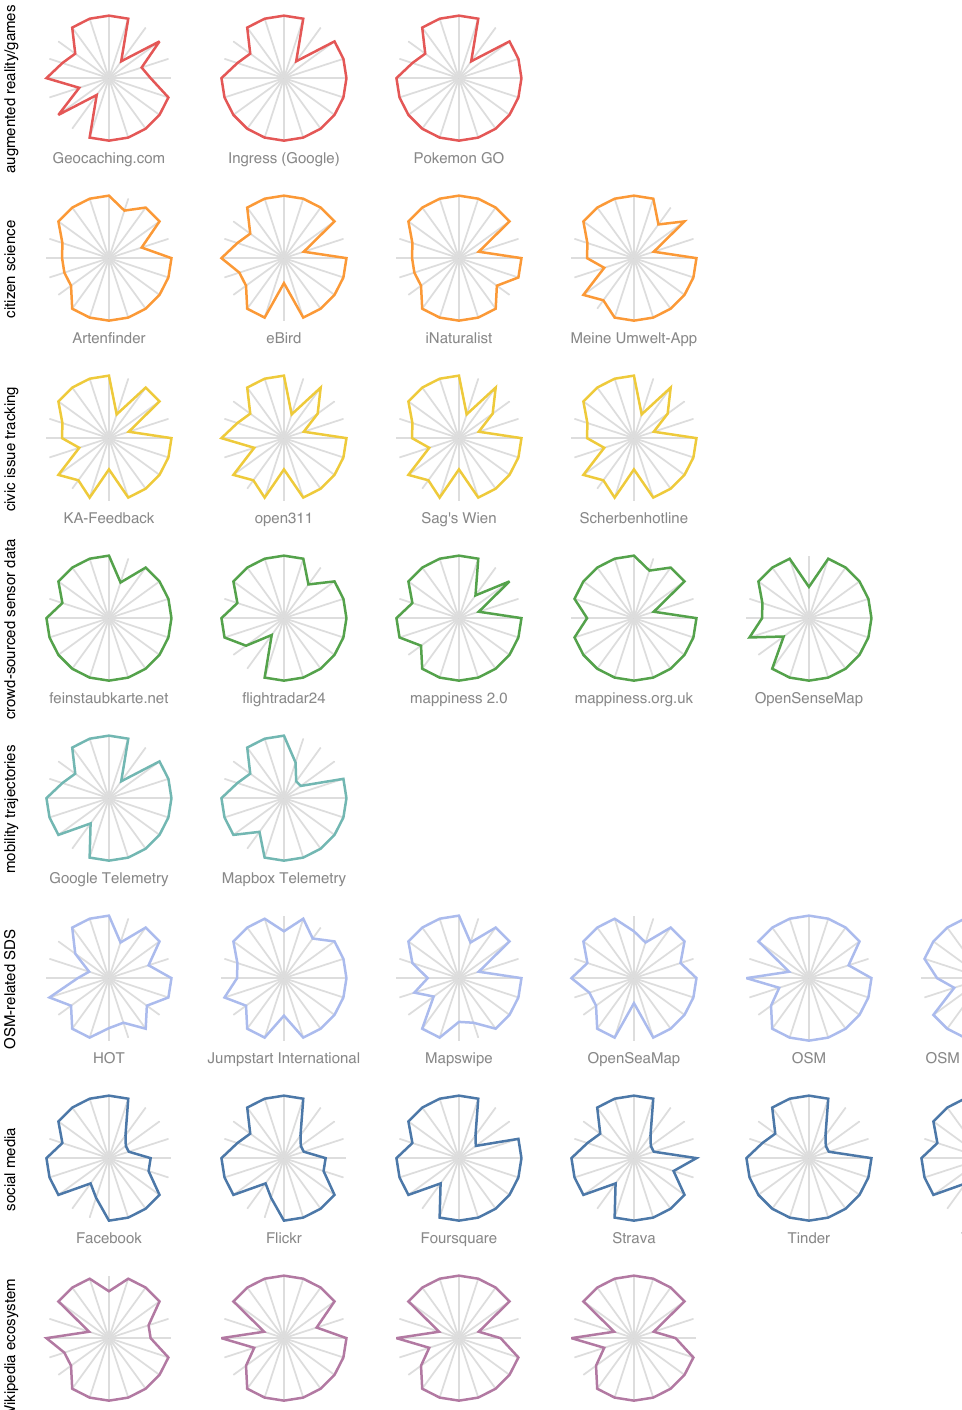
Figure 5. Individual spider charts of Geographical Shared Data Sources (GSDSs). The individual depiction of each GSDS allows for a grouping by